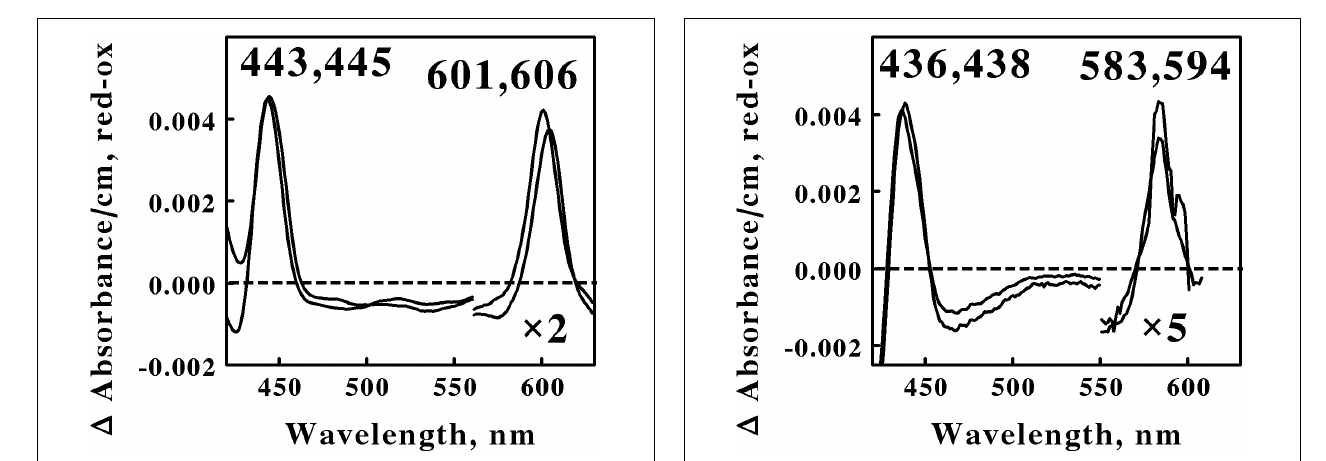
FIGURE 3 | Reduced minus oxidized difference spectra obtained when excess ferrous sulfate was mixed with intact cells of Ferrimicrobium acidiphilum (lower wavelengths) and Acidimicrobium ferrooxidans (higher wavelengths), representing the Actinobacteria. The number of cells present in 8 ml were 3.7 × 10 10 and 3.1 × 10 10 for F. acidiphilum and A. ferrooxidans , respectively. The absorbance values in the α regions of both spectra were multiplied by 2 to aid in the clarity of presentation.